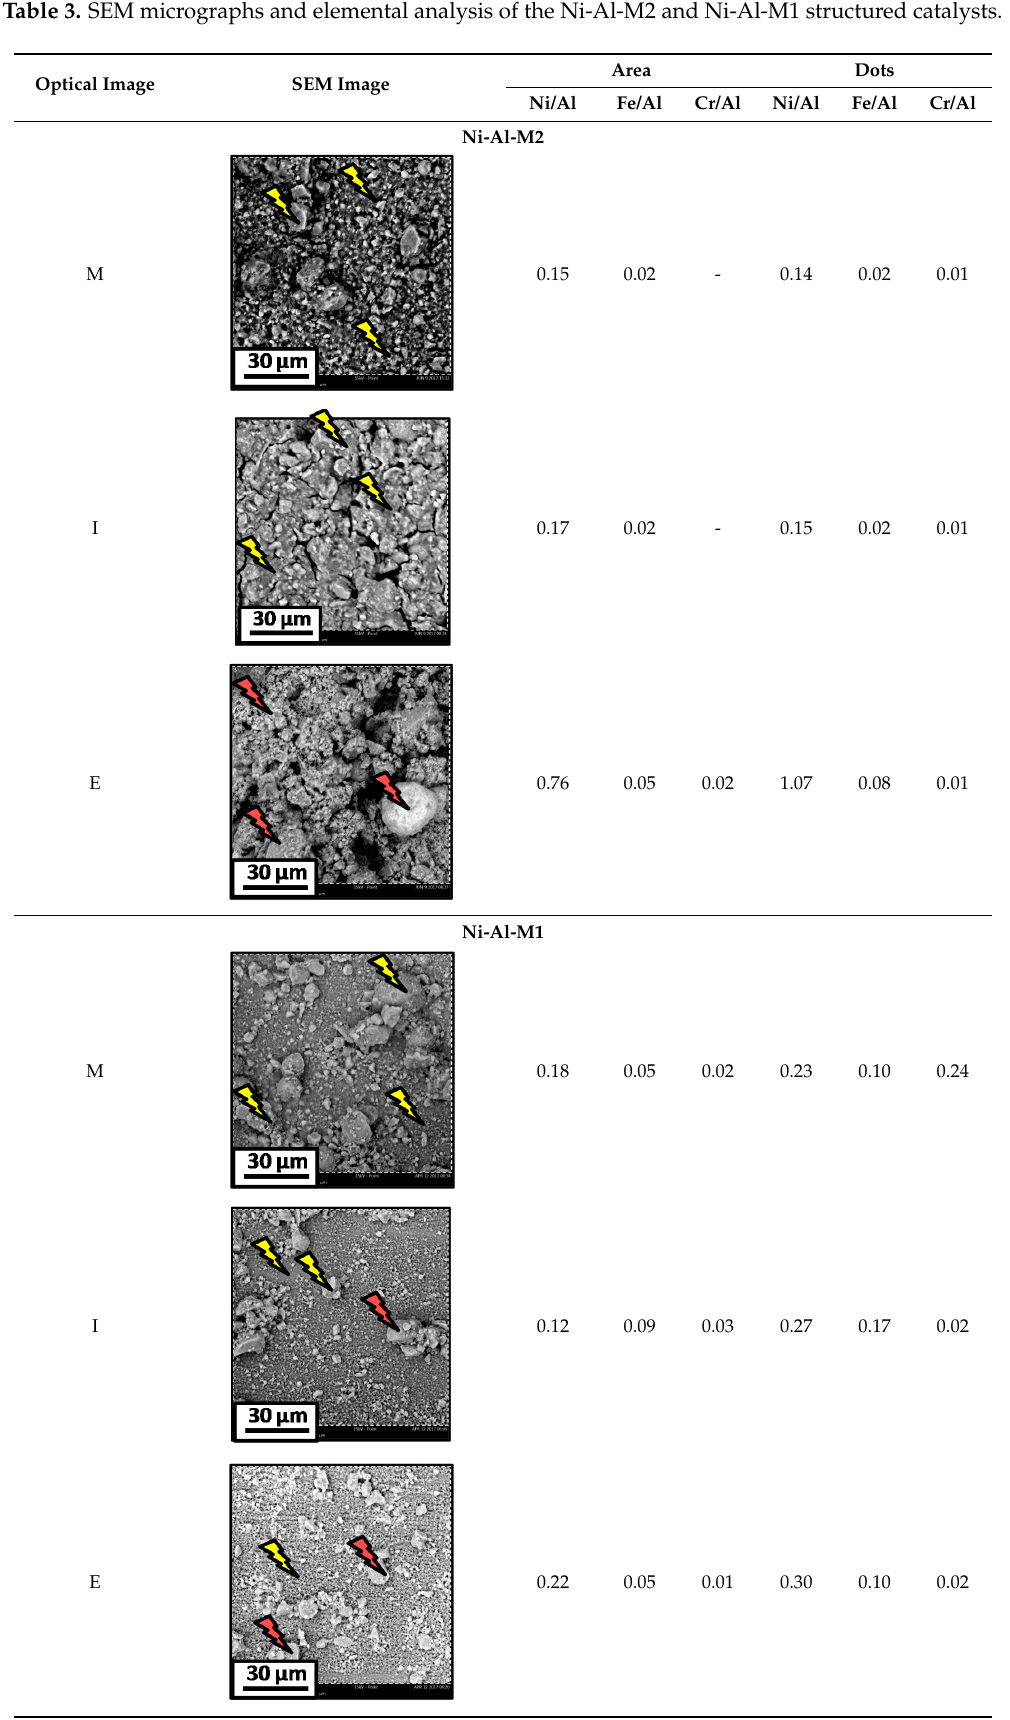
Optical Optical Image Table 3. SEM micrographs and elemental analysis of the Ni-Al-M2 and Ni-Al-M1 structured catalysts.